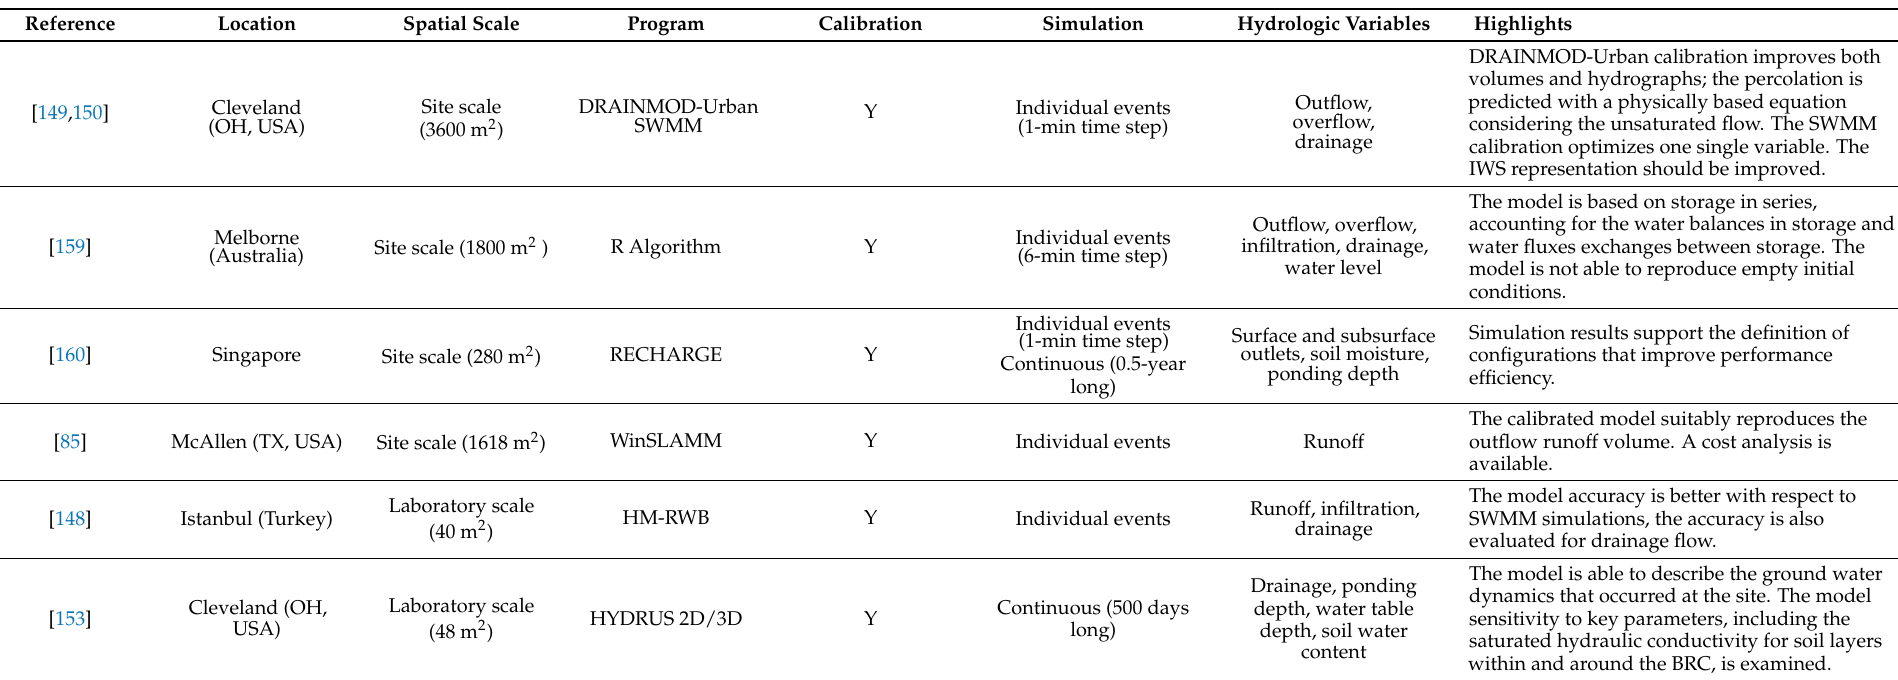
Table 5. Modeling studies of the hydrologic processes in BRCs on the site scale. For each study, the site characteristics, including the location and spatial scale, are reported together with the modeling features, including calibration phase, simulation conditions, and modeled